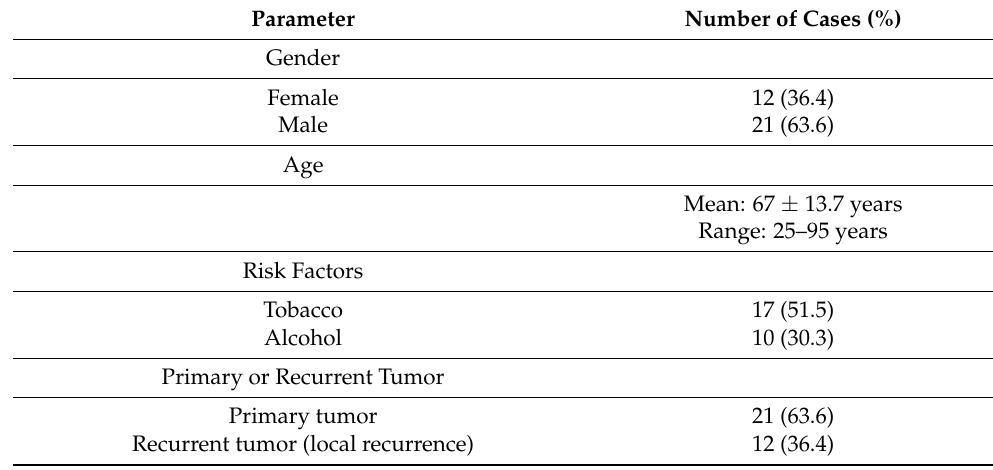
Table 1. Descriptive data regarding demographic and clinical features of the investigated